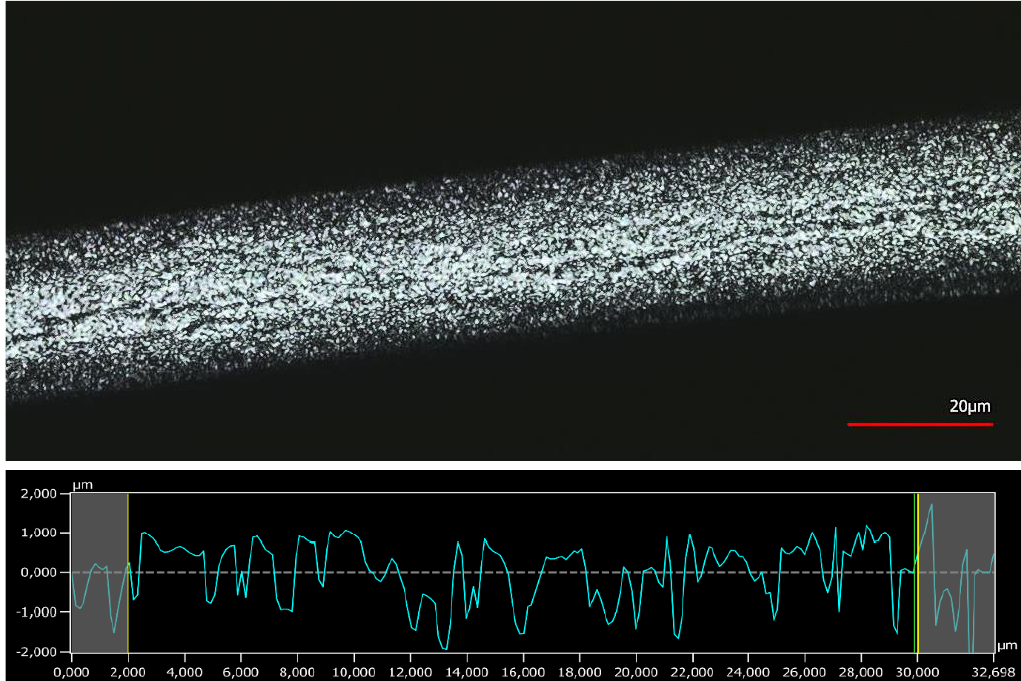
Figure 13. 3D confocal laser-scanning microscope picture of PA 6.6 fibre modified using SW and roughness profile.